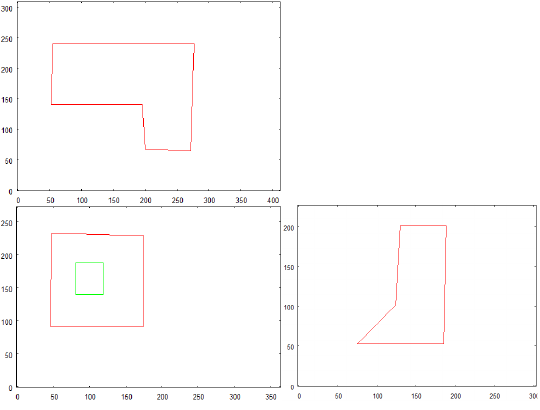
Figure 14. Result of vectorization of projections of building “II”. Vectorized images presented in Figures 12 and 14 are used for creating 3D model. The result of 3D model creation algorithm for structure “I” is shown in Figure 15. The result for structure “II” is in Figure 16.